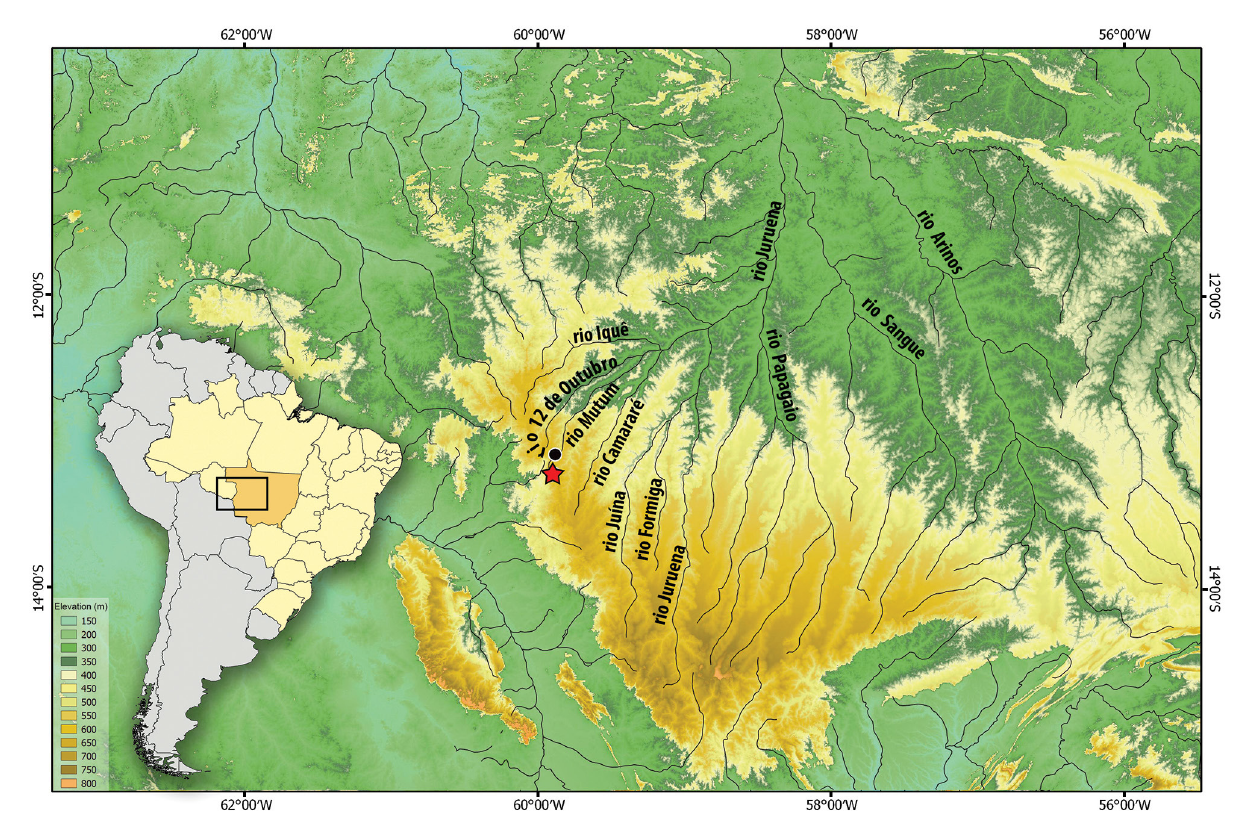
FIGURE 3 | Distribution of Hyphessobrycon comodoro in the upper rio Mutum, rio Juruena basin, Brazil. Red star (type locality), black dot (occurrence of other paratypes). Symbol can represent more than one collection